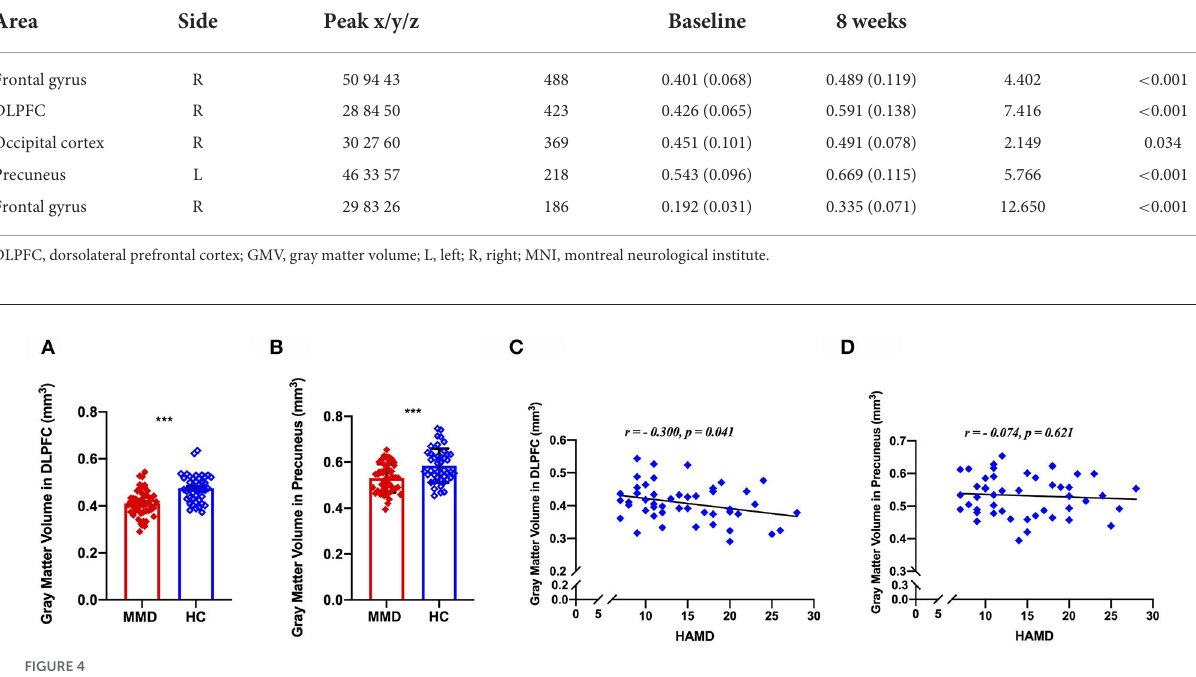
were significantly positively correlated with HAMD scores in patients with MMD; (2) patients with MMD showed